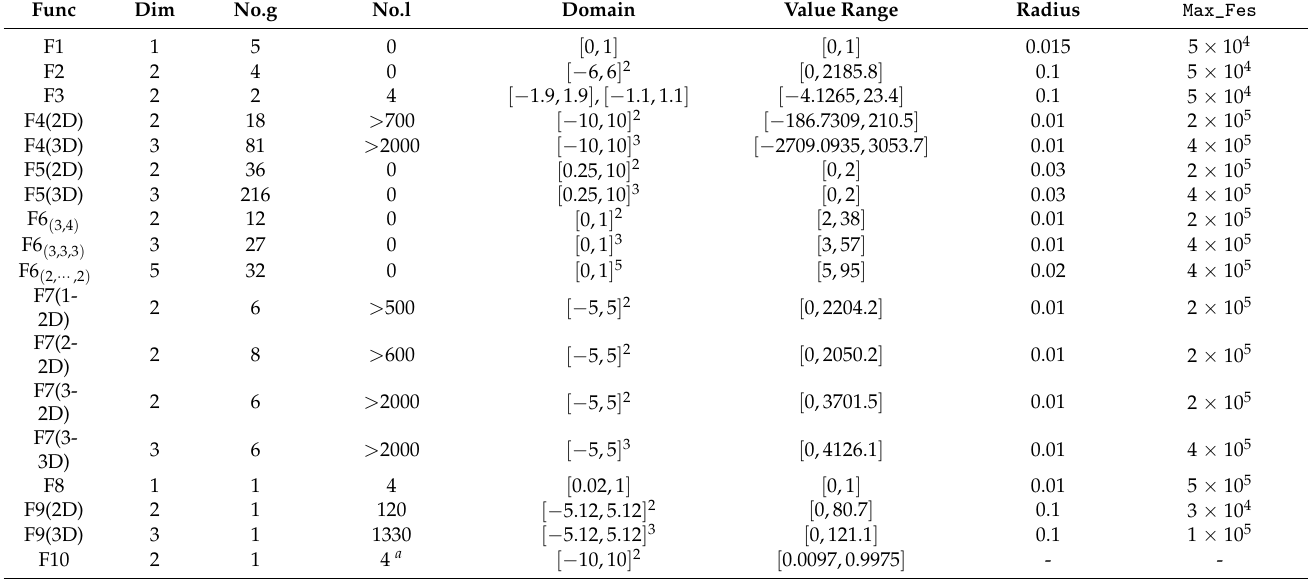
Table 2. The parameters of the tested